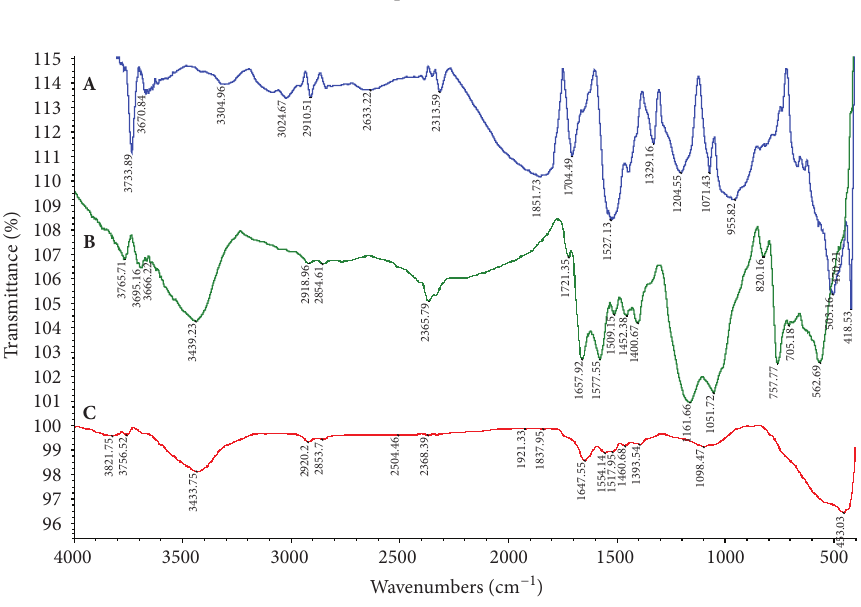
F 5: Fourier transform spectra of A MWNT-COOH, B MWNT-(11H-indeno[1,2-b]quinoxaline-11-ylidene)benzene-1,4-diamine, and C MWNT-